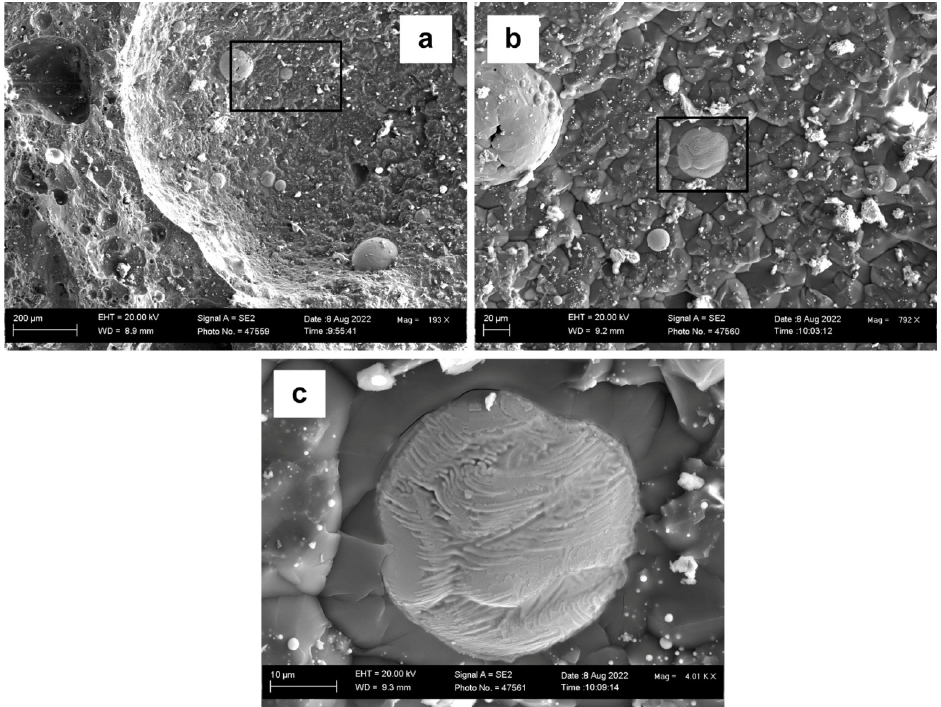
Figure 10. BSE image of dome in MP5 slag sample: ( a ) at 193× magnification; ( b ) at 792× magnifica- tion; ( c ) at 4010× magnification.